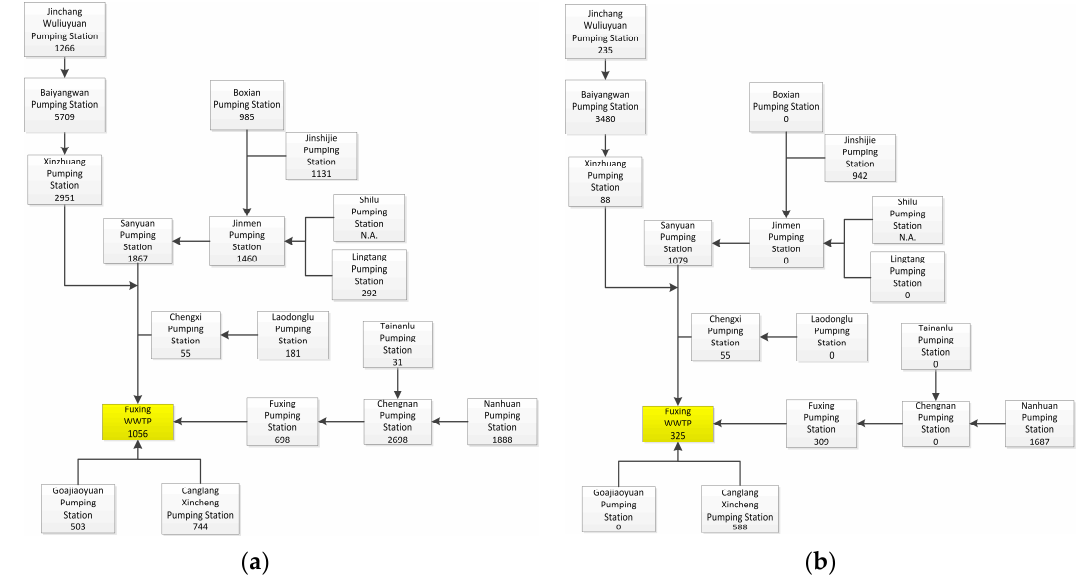
Figure 10. The storage capacity evaluation result (unit: m 3 ). ( a ) Storage capacity of each pumping- station service area on a dry weather day. ( b ) Storage capacity of each pumping station under multi- year average precipitation.